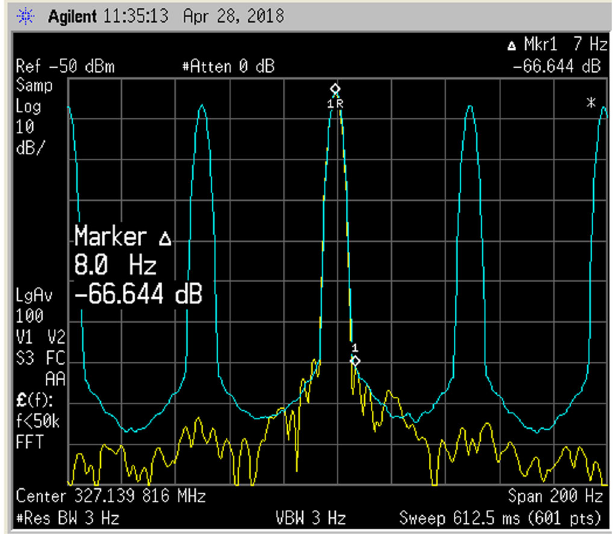
FIG. 15. Measured power spectral density of the rf signal generator and the cavity field in pulsed